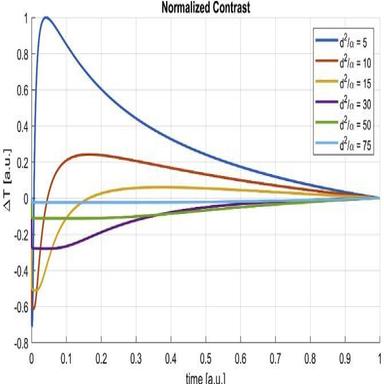
Analytical normalized thermal contrasts for different defect depths from surface (dark blue) to deep defects (light blue). (For interpretation of the references to color in this figure legend, the reader is referred to the Web version of this article.)